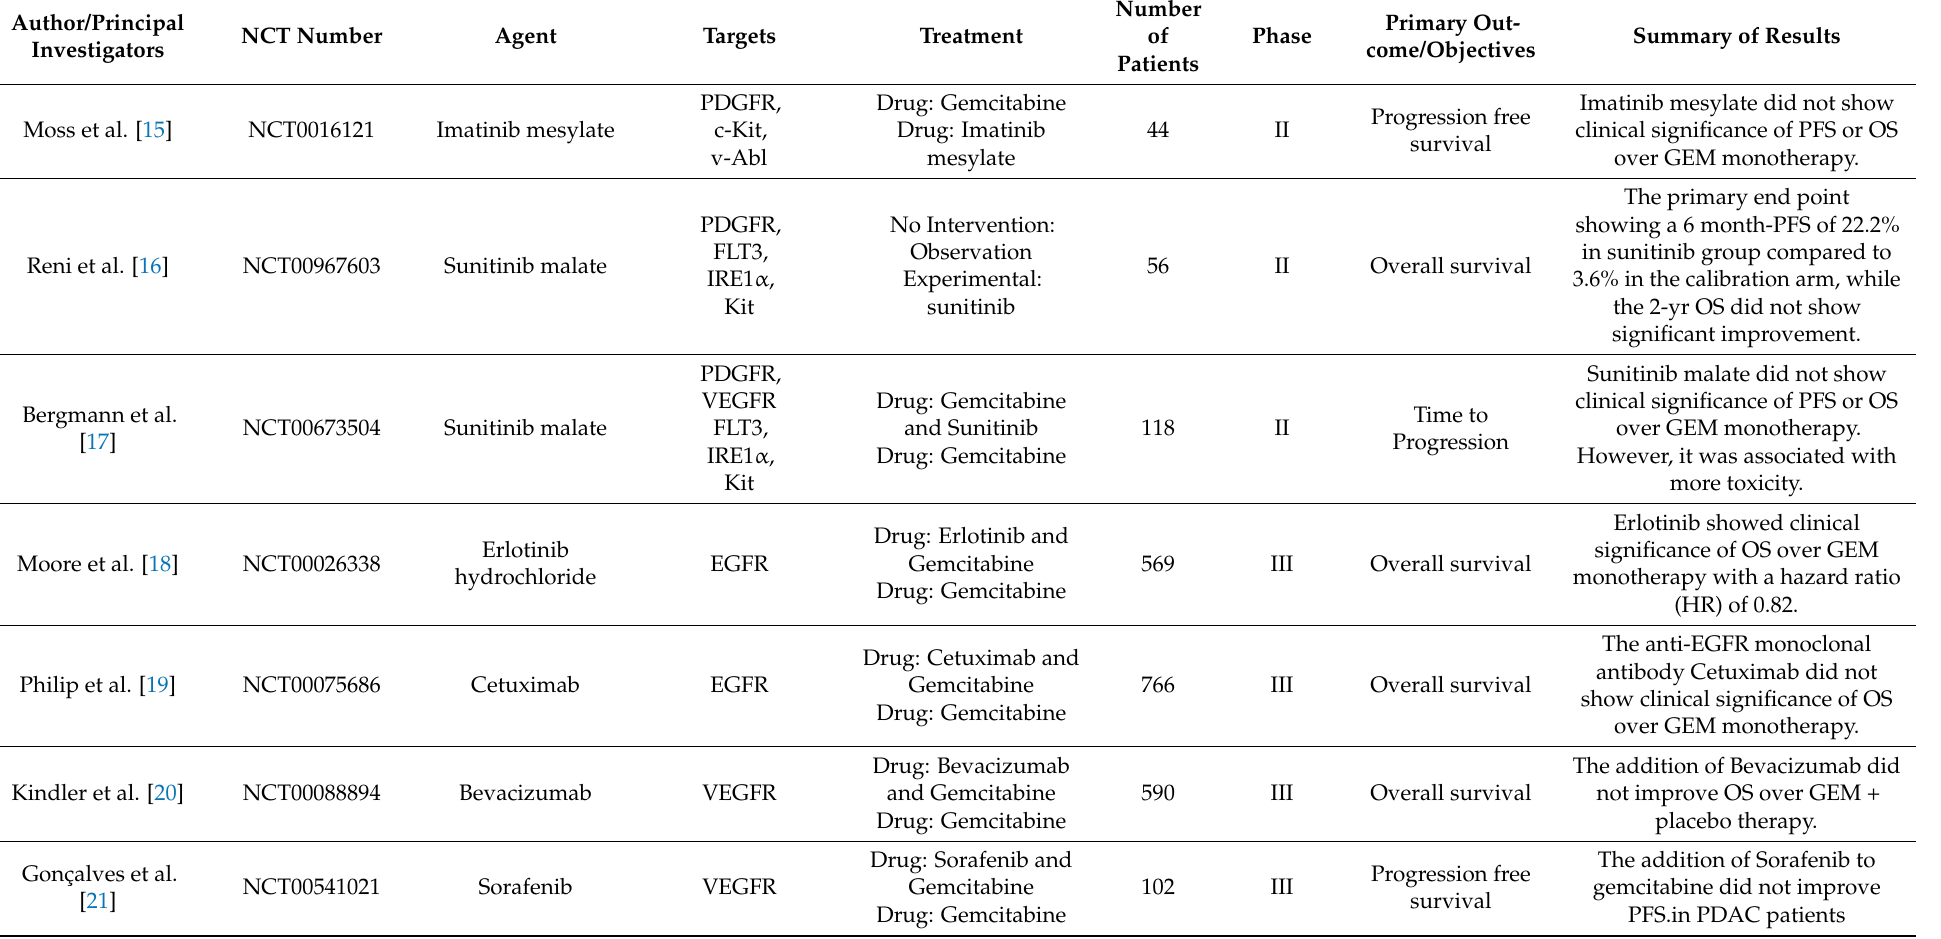
Table 1. Representative completed clinical trials assessing the efficacy of RTKs inhibitors on patients with